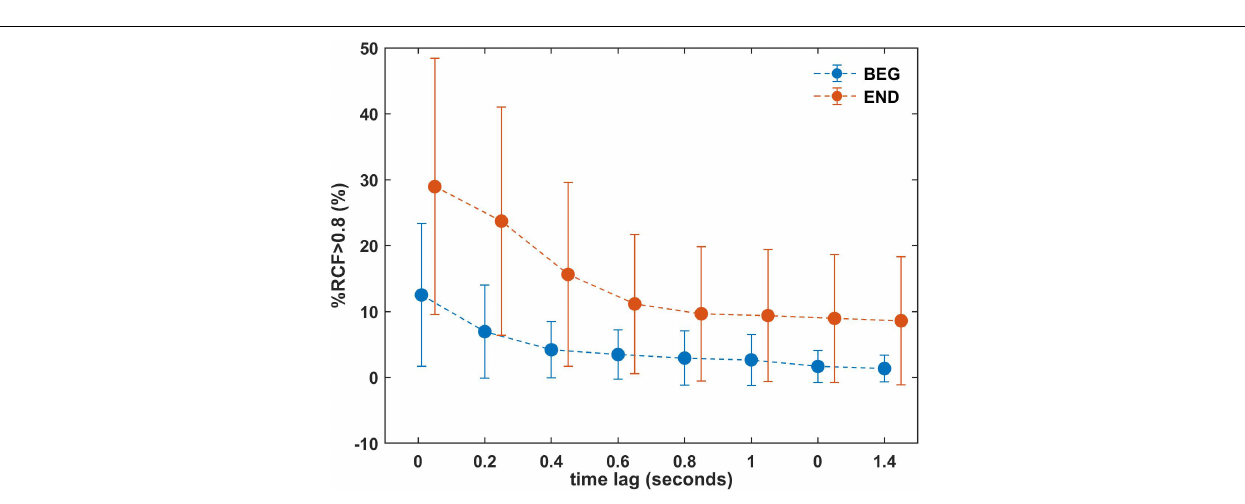
FIGURE 7 | Mean %RCF > 0.8 for the BEG and END segments with increasing time lags 0, 0.2, 0.4 ... 1.4 s for one selected window ( W = 150). The results for the final part are shifted and dotted line is plotted to visualize the trend. Error bars represent the standard deviation. BEG: initial segment of the trial and END: final segment of the